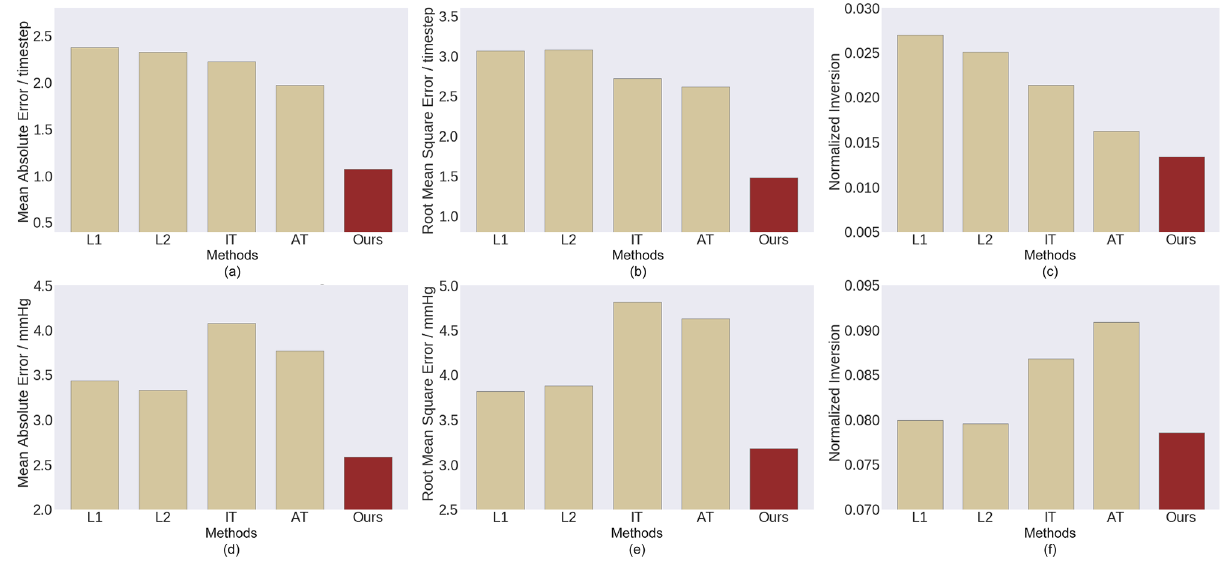
Figure 4. Estimation errors. The first row is for the parameter estimation of synthetic signals, and the second row is for the systolic blood pressure estimation.